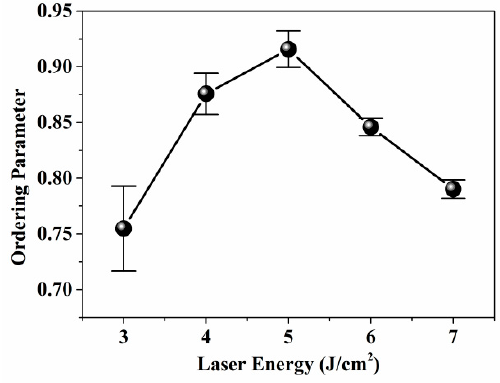
Figure 3. The ordering parameter and FWHM of FePt (001) peak.